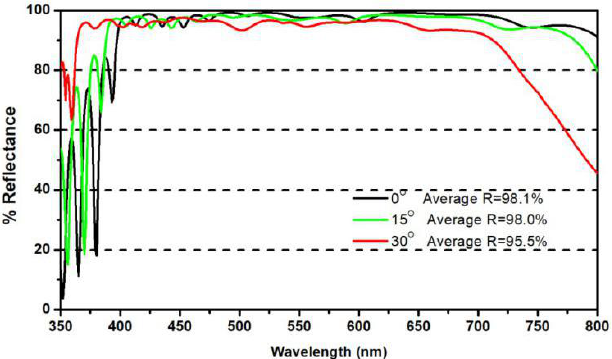
Figure 3. Calculated reflectance of designed 30 layers high-reflection (HR) coating at incident angles of 0° (black line), 15° (green line), and 30° (red line).